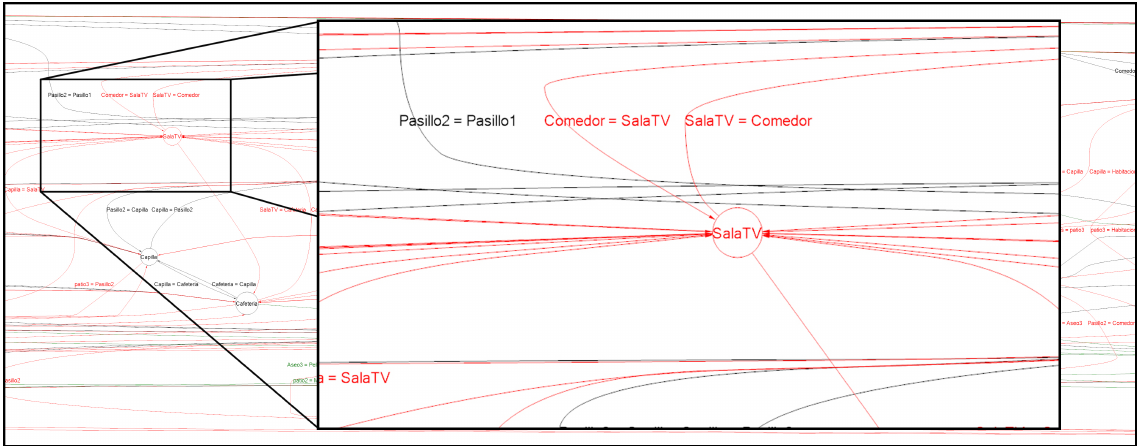
Figure 4. Detail of edition distance between 7th September and the last behavior model learned